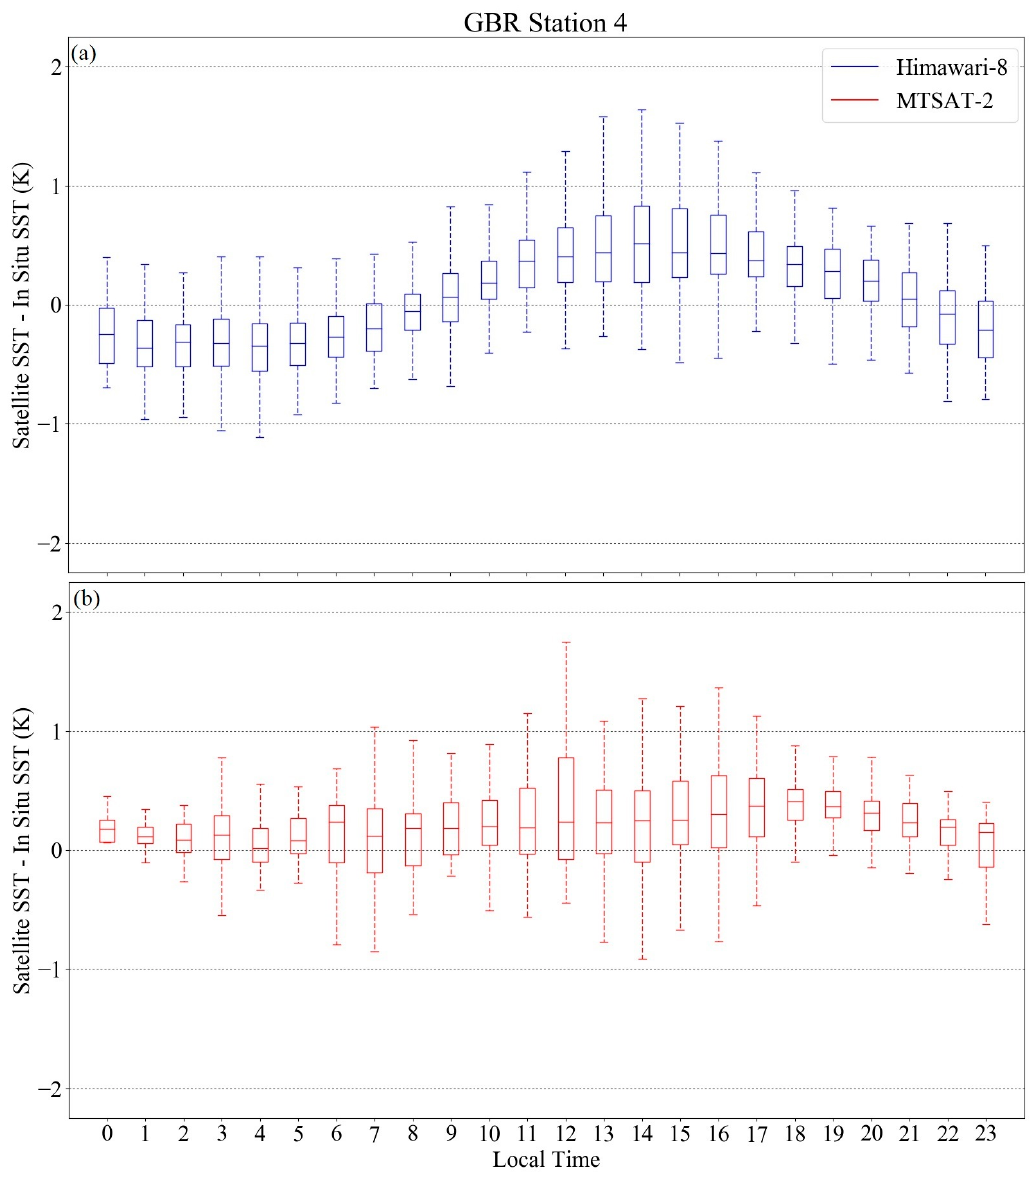
Figure 8. As Figure 7, but for GBR Station 4 at 18.49°S, 146.87°E with in situ temperatures measured at a depth of 1.9 m. Differences of SSTs from Hiawari-8 are shown in blue in ( a ), and from MTSAT-2 in red in ( b ).